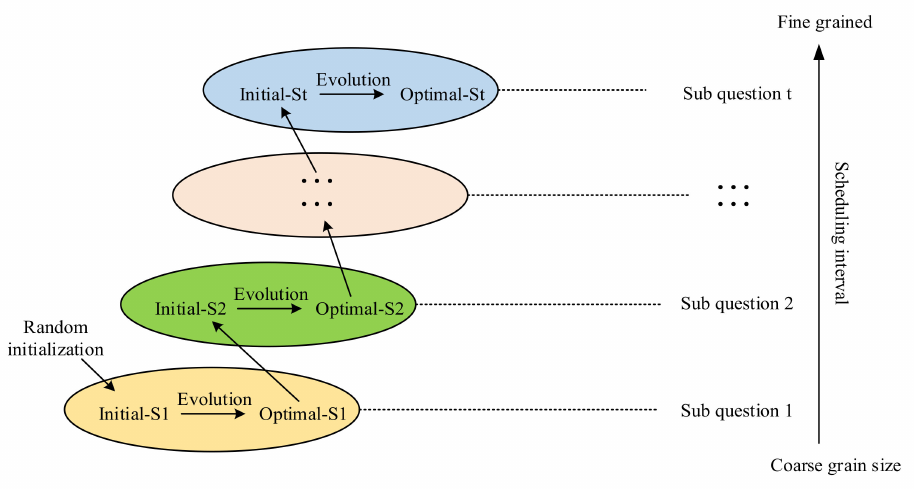
Figure 3. Schematic diagram of decomposition method from coarse to